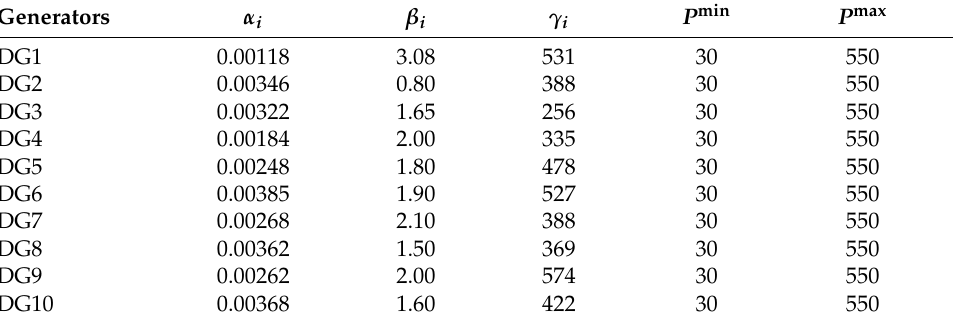
Figure 5. ( a ) Topology G . ( b ) Topology G 1 . ( c ) Topology G 2 . Table 3. Generator cost function coefficient.